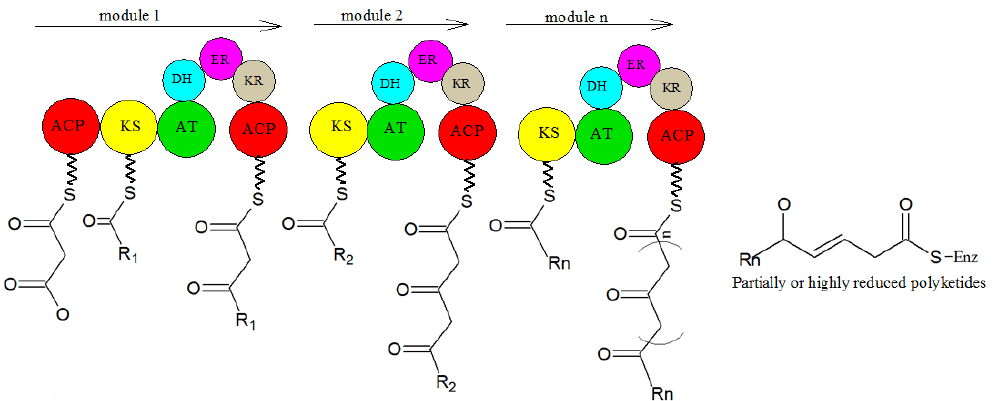
Figure 12. The biosynthesis of PKs [77] .